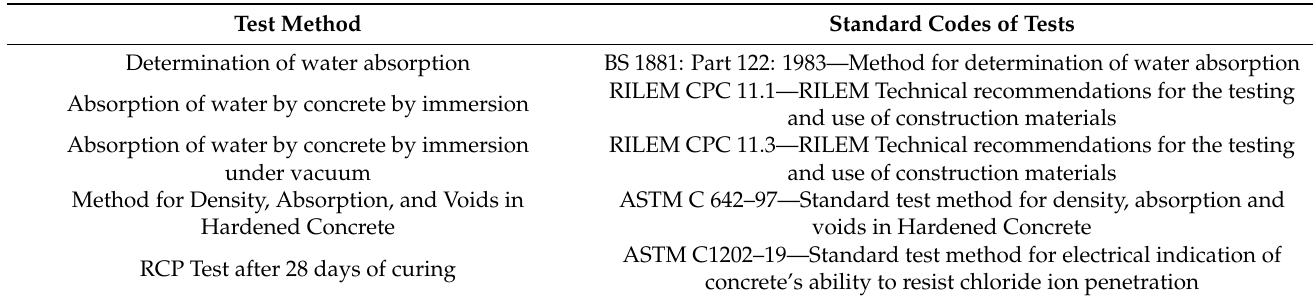
Table 1. Investigated test methods and relevant standard test procedures